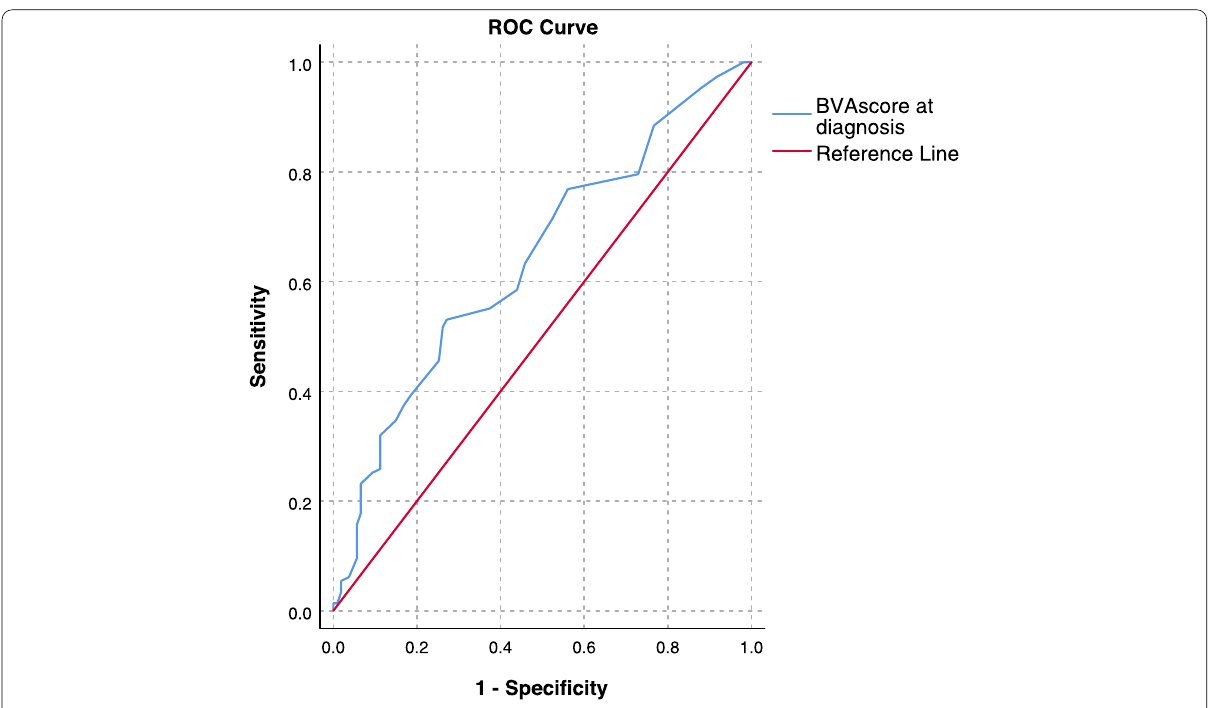
Fig. 1 Receiver operating characteristic (ROC) curve of relapse by BVAS at diagnosis. BVAS at diagnosis has at least one tie between the positive actual state group and the negative actual state group. Area: 0.641, P